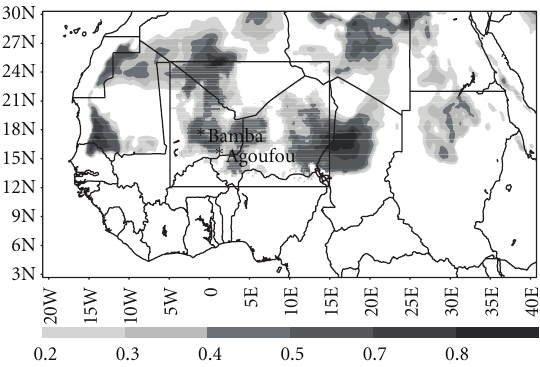
Figure 1: WRF-Chem model domain for 30 km horizontal grid EXP30 and for 10km horizontal grid EXP10 (small square). Shaded area represents percentage of erodibility as dust source function for the GOCART scheme. Letters indicate locations of meteorological stations within EXP10 domain operational during AMMA